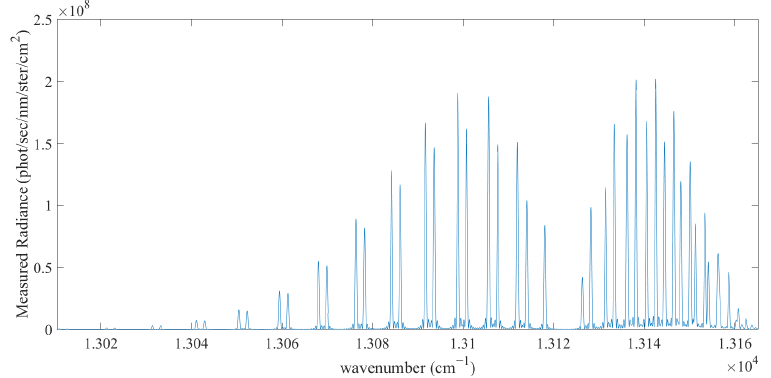
Figure 3. Simulated limb observation spectrum in a field of view of 92 km.